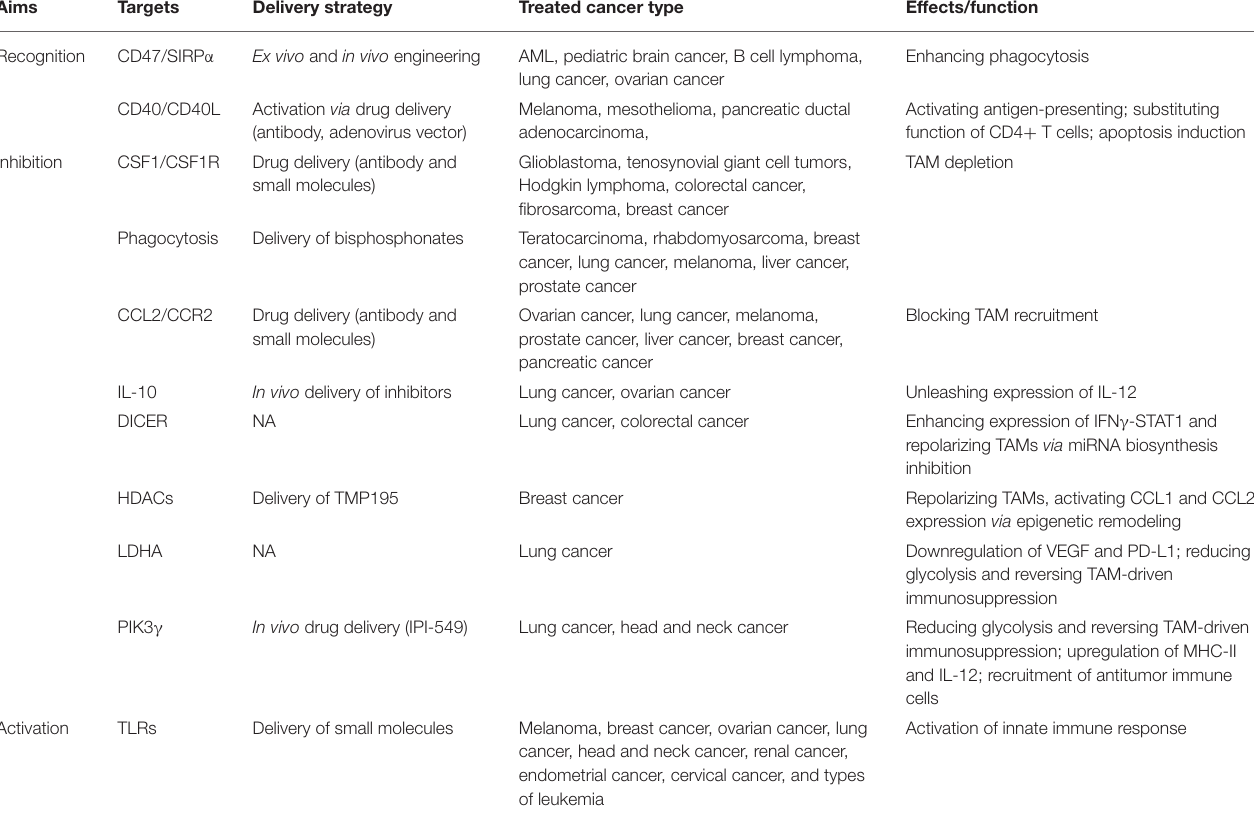
TABLE 2 | In vivo or in vitro engineering strategies for macrophage-based immune therapy.